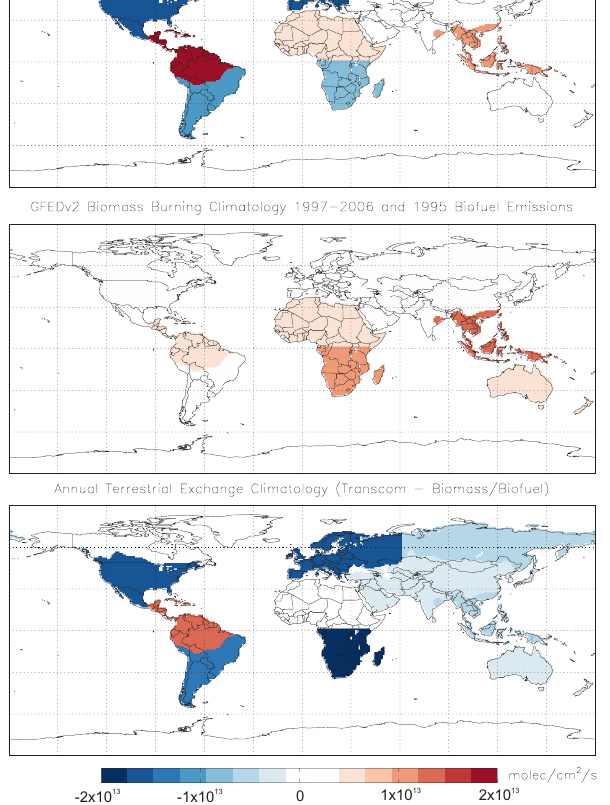
Fig. 2. Annual terrestrial exchange from Baker et al. (2006) for a climatology representing 1991–2000, with values distributed equally within each of the 11 TransCom3 land regions (top). Sum of GFEDv2 climatology of biomass burning emissions for 1997– 2006 with biofuel burning emissions for 1995 distributed as in the previous panel (middle). Combination of two earlier panels giving the constant annual terrestrial exchange in the model